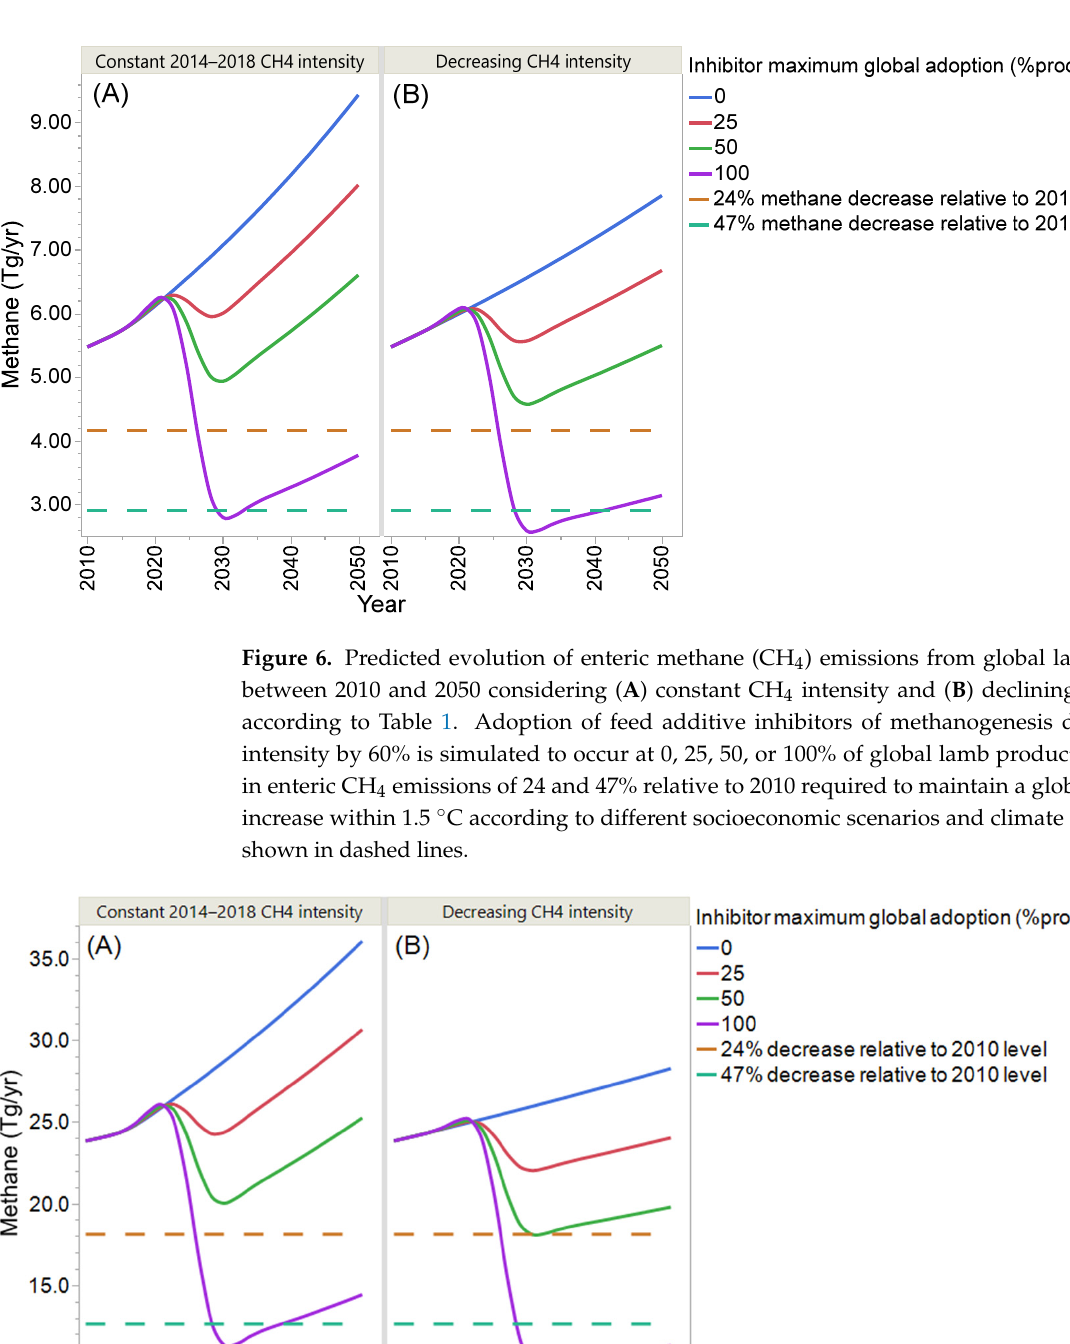
Figure 8. Predicted evolution of enteric methane (CH 4 ) emissions from global beef, lamb, and bovine milk production between 2010 and 2050 considering ( A ) constant CH 4 intensity and ( B ) declining CH 4 intensity according to Table 1. Adoption of feed additive inhibitors of methanogenesis decreas- ing CH 4 intensity by 60% for beef, lamb, and milk production is simulated to occur at 0, 25, 50, or 100% of global production. Decreases in enteric CH 4 emissions of 24 and 47% relative to 2010 re- quired to maintain a global temperature increase within 1.5 °C according to different socioeconomic scenarios and climate models [15] are shown in dashed lines. 6. Cost Effectiveness and Co-Benefits of Inhibiting Methanogenesis Successful adoption of antimethanogenic strategies requires that they are economi- cally attractive to producers [50]. The inclusion of 3-NOP, Asparagopsis , or any other in- hibitor of methanogenesis developed in the future in ruminant diets would raise feed